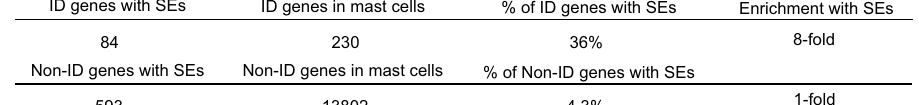
Fig. 1 Super-enhancers are enriched in mast cell identity genes. a The H3K27ac ChIP-seq peaks in resting BMMCs were used for analyzing super- enhancers (SEs) and typical enhancers (TEs) using Ranking Of Super Enhancer (ROSE). b Genomic distributions of the TEs and SEs. c Representative IGV tracks of the mast cell identity (ID) genes and non-ID genes. The small bars below the tracks indicate TEs and the large bars indicate SEs. Data a – c represent two biological samples. d SEs are enriched in the mast cell ID genes. The ChIP-seq IGV tracks are generated from one biological sample, representing two biological replicates with similar